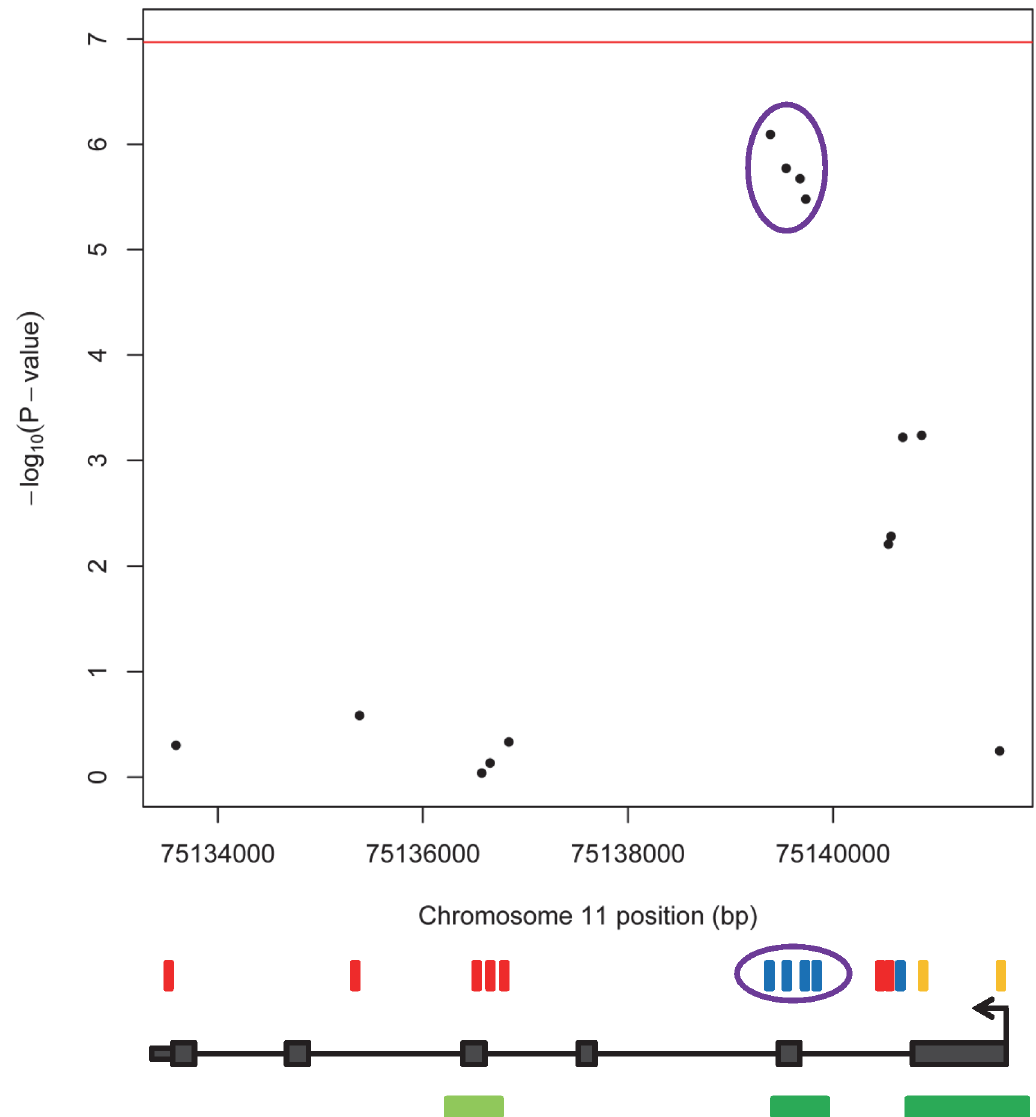
Fig 2. KLHL35 methylation association results in NFCS. All KLHL35 CpGs present on the Illumina 450K chip are shown as rectangles above the gene diagram. Each CpG is colored according to its mean absolute β -value adjusted for technical factors: red (70 – 100%), blue (30 – 70%), and orange (0 – 30%). The four CpGs that are circled in purple are near the second exon and show the strongest associations. The green rectangles below the gene diagram mark the CpG islands (UCSC, GC content (cid:1) 50%, length > 200 bp with islands < 300 bp shown in light green, Observed/ Expected CpGs > 0.6). The red horizontal line denotes the strict threshold for epigenome-wide significance based on a conservative Bonferroni correction for 465525 tests (p < 1.07x10 -7